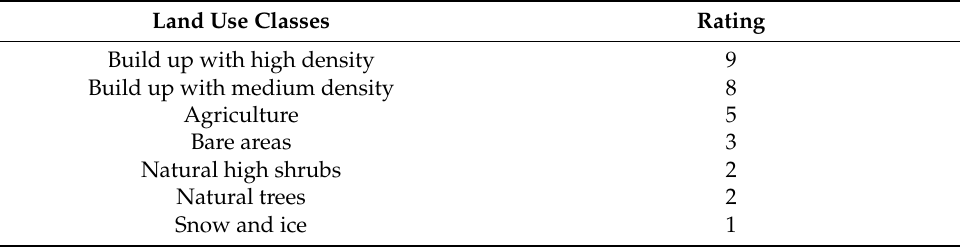
Figure 7. Map showing the anthropogenic impact of study area. Table 4. Ratings assigned to land use